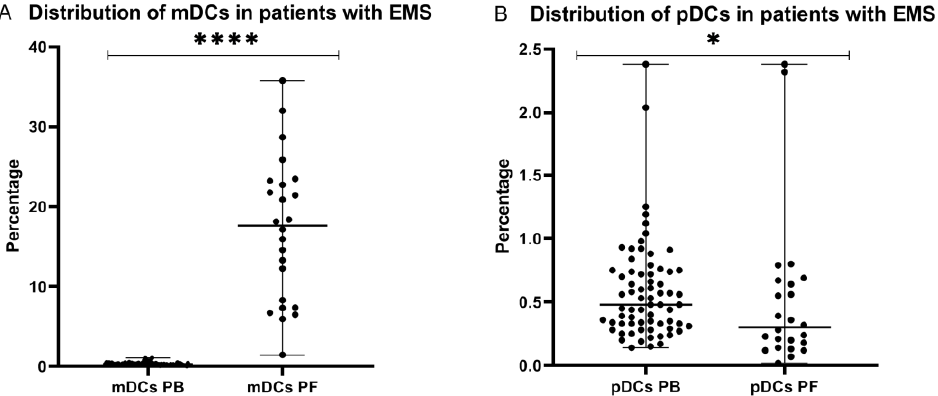
Figure 1. Percentage of mDCs ( A ) and pDCs ( B ) in peripheral blood and peritoneal fluid in patients with endometriosis. The median values with the following signs indicate statistically significant differences: * p < 0.05, **** p < 0.0001.